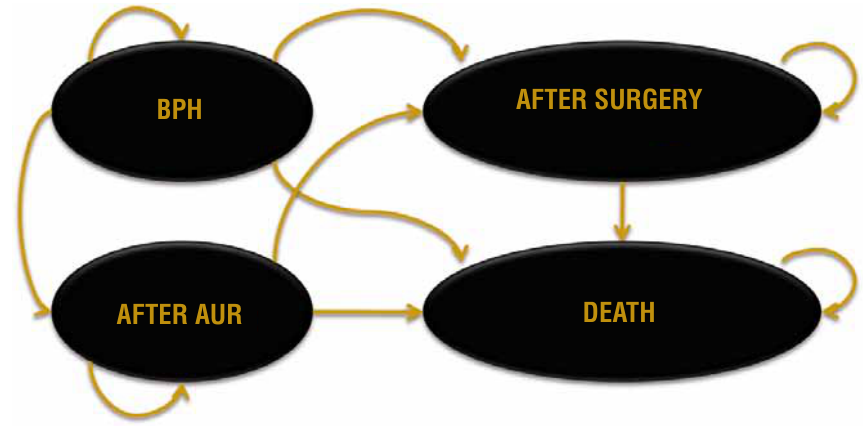
Figura 1- Desenho de Markov com os estados de saúde considerados